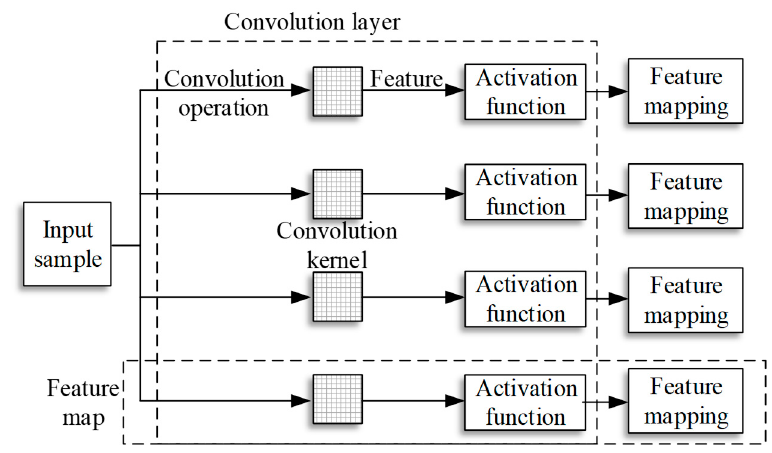
Figure 2. Convolutional layer structure.